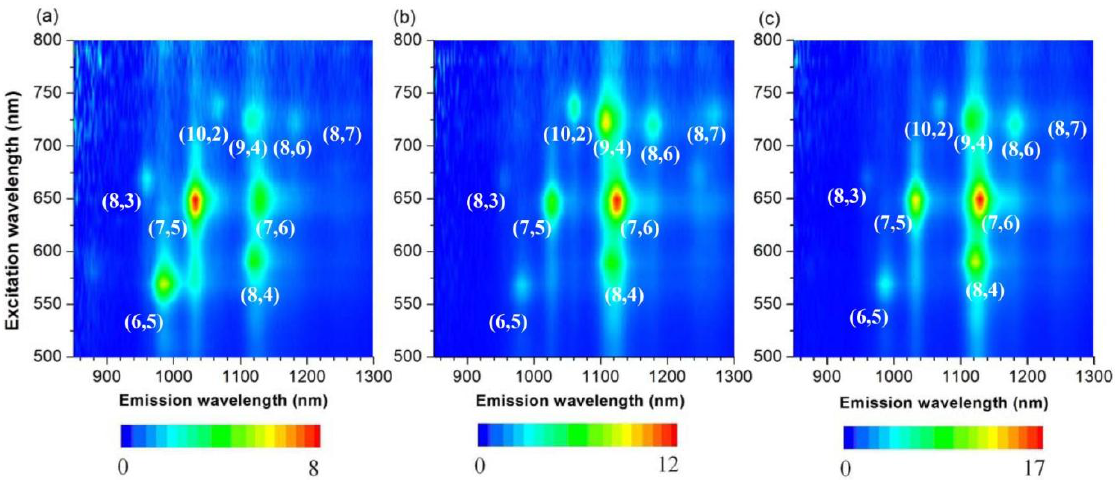
Figure 4. Photoluminescence spectra of D O/SDBS (sodium dodecyl benzene sulfonate) 2 solutions of 76-CoMoCAT before ( a ); and after extraction with ZnOEP ( b ); and MnOEP ( c ).